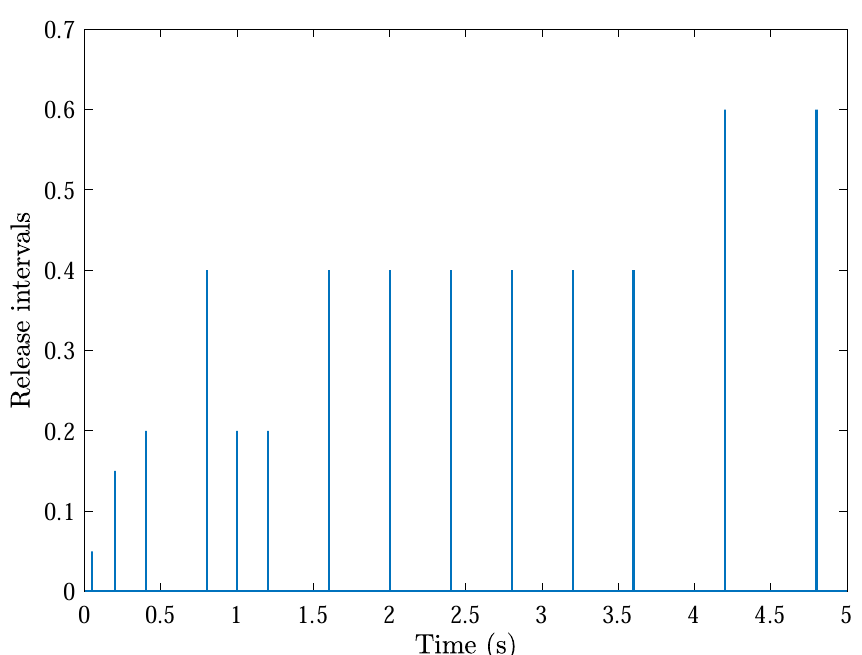
Figure 4. Event-triggered communication instants and release intervals of UAV 1.